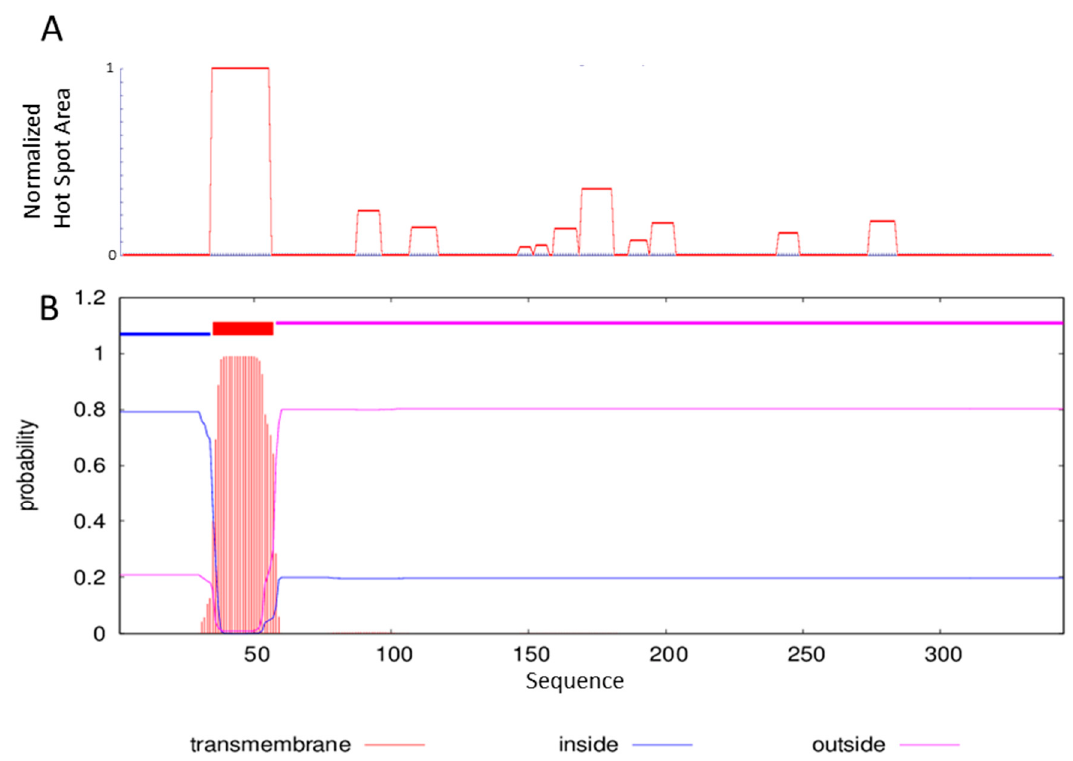
Figure 2. FlmC aggregation profile using the servers AGGRESCAN ( A ). Prediction of transmembrane helices by TMHMM server ( B ).